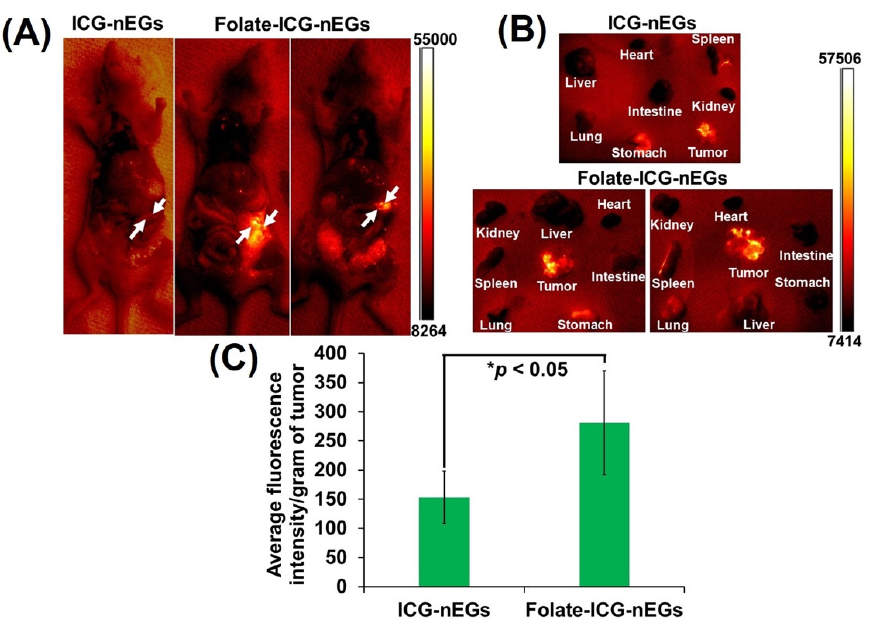
Figure 7. ( A ) Open-abdomen whole-body NIR fluorescence images of immunodeficient mice inoc- ulated with intraperitoneal SKOV ovarian cancer cells at 24 h post-intravenous administration of ICG-nEGs, or folate-functionalized ICG-nEGs (folate-ICG-nEGs). Images are falsely colors with the emission intensity scale shown on the right side. White arrows point to the tumors. ( B ) Corre- sponding images of the extracted organs and tumors from each mouse. ( C ) Average fluorescence emission intensity normalized to weight of each tumor, and subsequently averaged among the number of homogenized tumors ( n = 3 tumors from three different animals). Asterisk indicates a statistically significant difference ( p < 0.05). For imaging of the whole body, and the extracted or- gans and tumors, photoexcitation wavelength was 710 ± 25 nm, and emission > 785 nm was rec- orded. Homogenized tumors were photoexcited at 720 nm, and emission in 735–900 nm band was recorded.